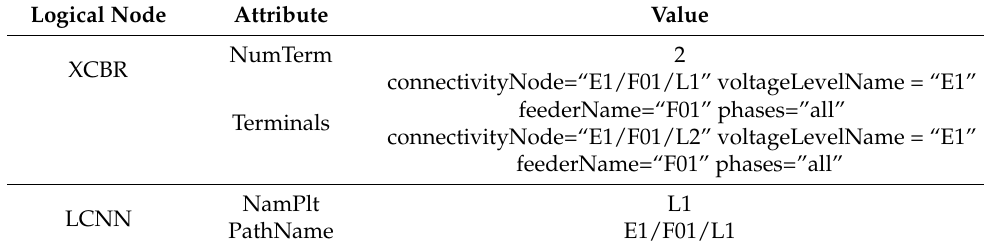
Table 2. Logical node and its